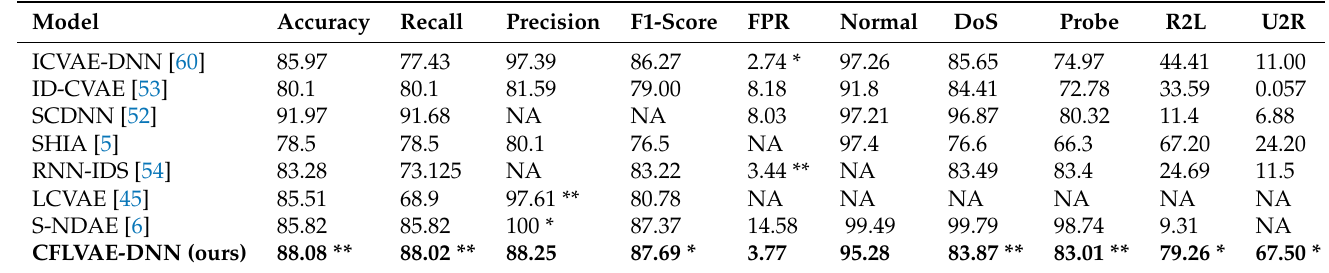
Table 2. Comparative study (in %) of CFLVAE-DNN with the state-of-the-art techniques on the KDDTest+ dataset (NA means not available, * ranked first, ** ranked